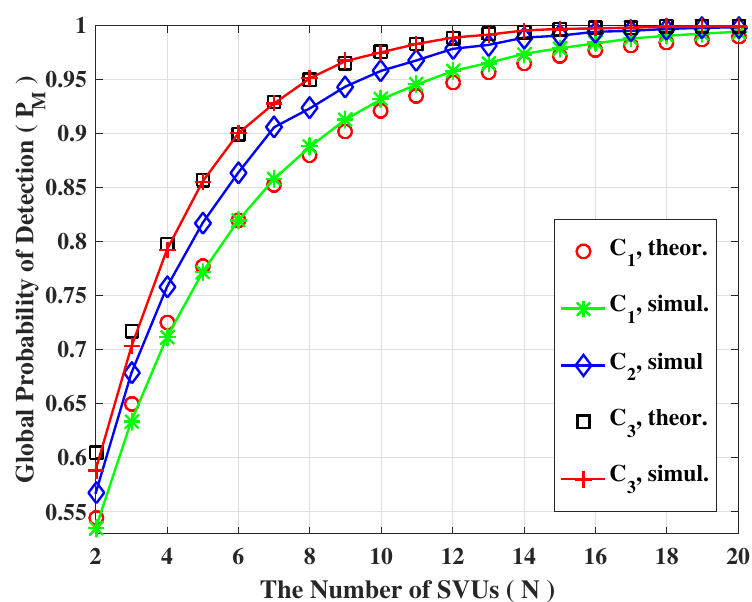
Figure 7. The detection probability of soft fusion scheme for various number of SVUs ( K = 50, η 0 = − 8 dB, P F = 0.1, C 2 : f d T s = 0.01).